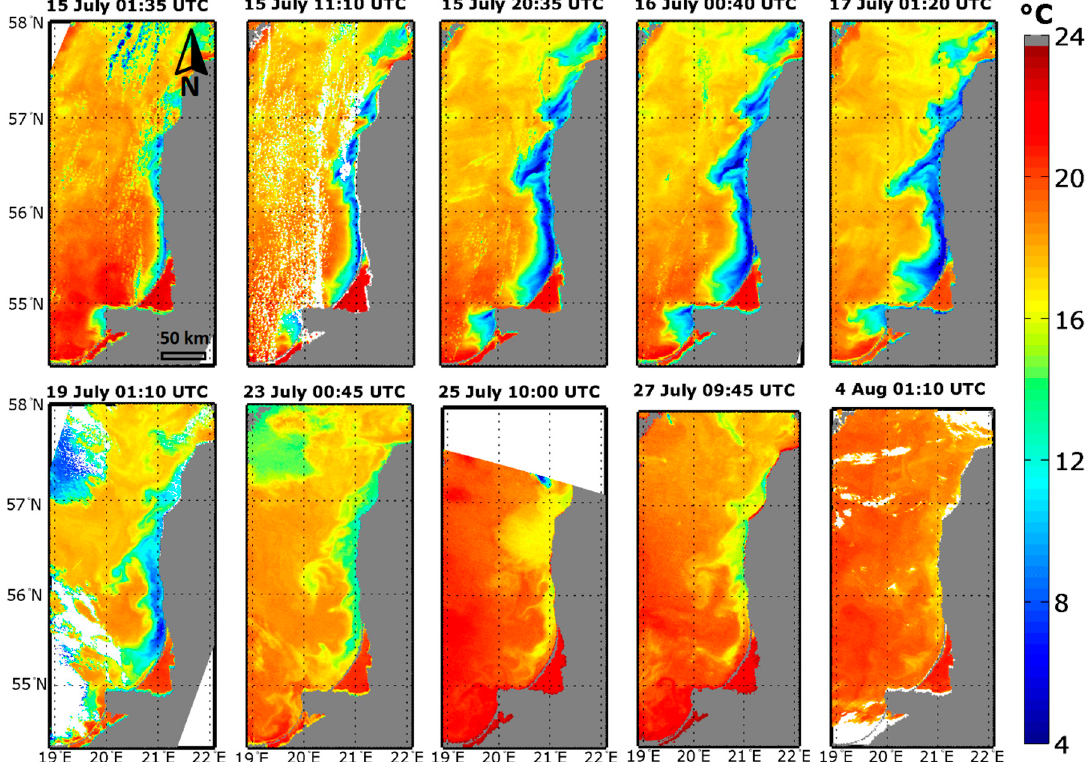
Figure 11. Development of a major coastal upwelling event in the SE Baltic Sea in the summer of 2006.